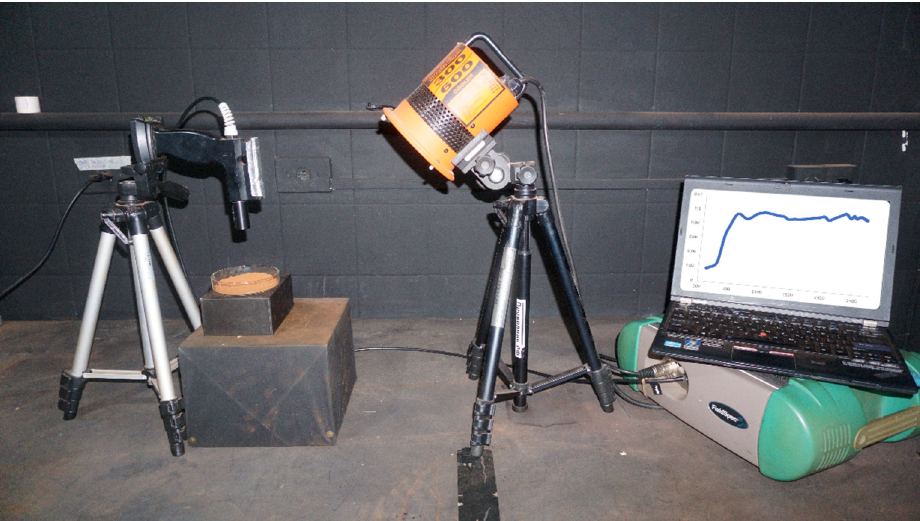
Figure 3. Experimental setup used to obtain spectral data from soil